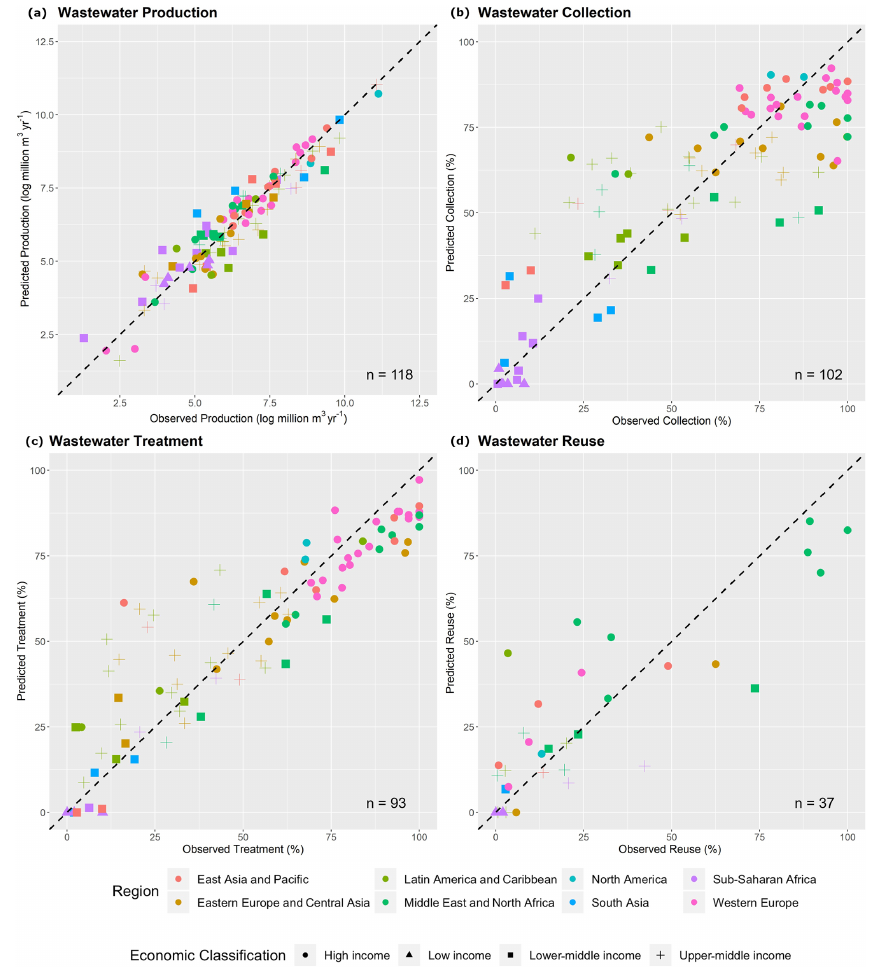
Figure 2. Observed versus predicted wastewater production (a) , collection (b) , treatment (c) and reuse (d) from regression